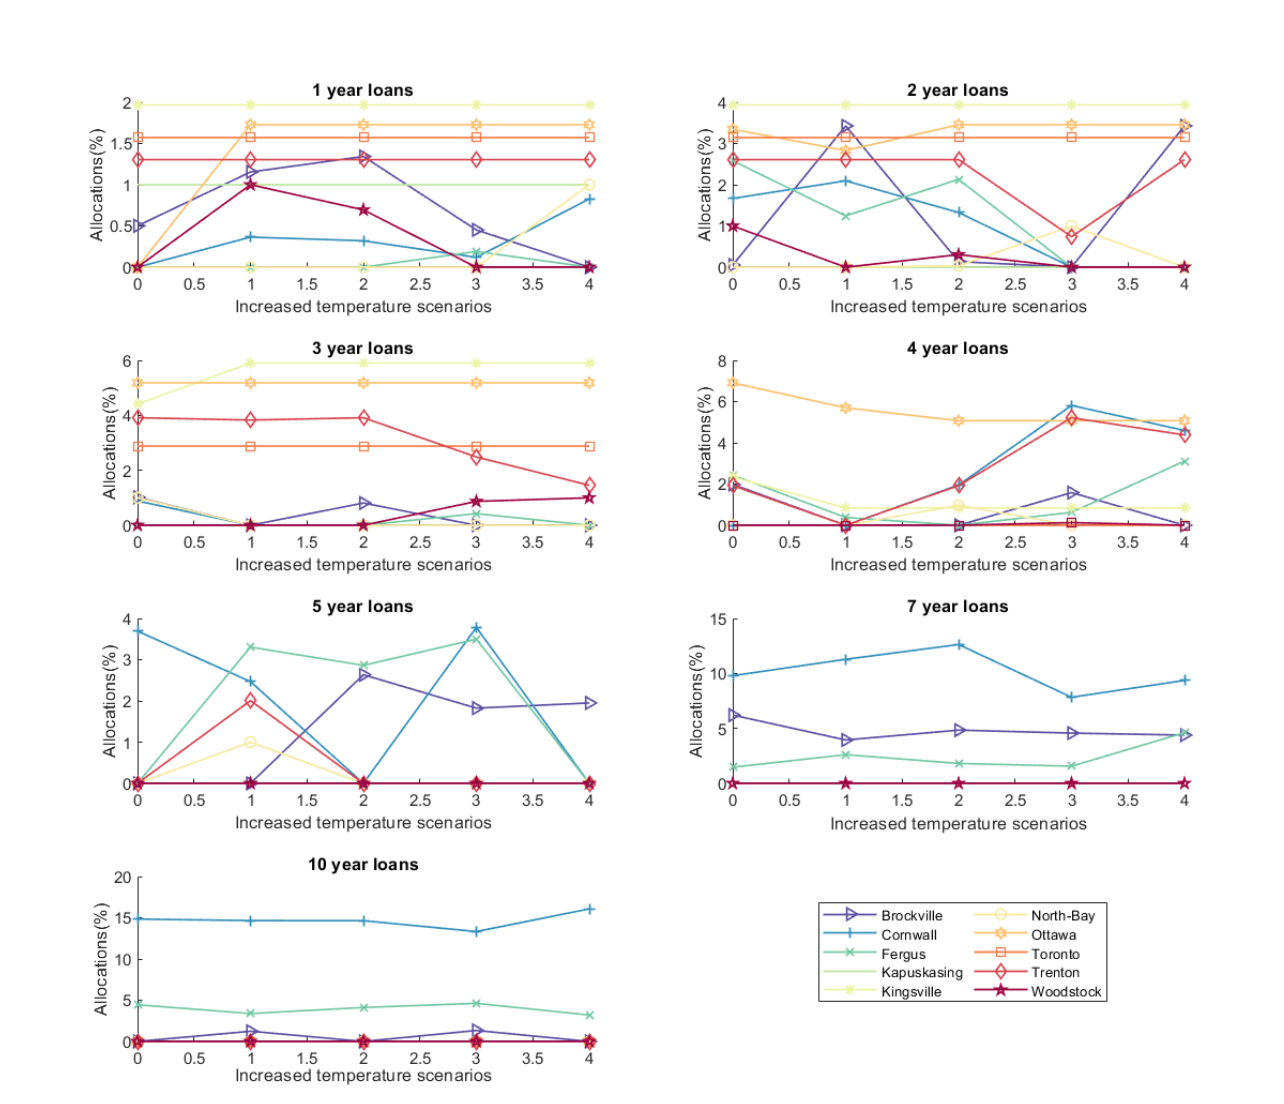
Figure 5. Allocations to each tenor of loan in each region under five different 1 ◦ C increased temperature